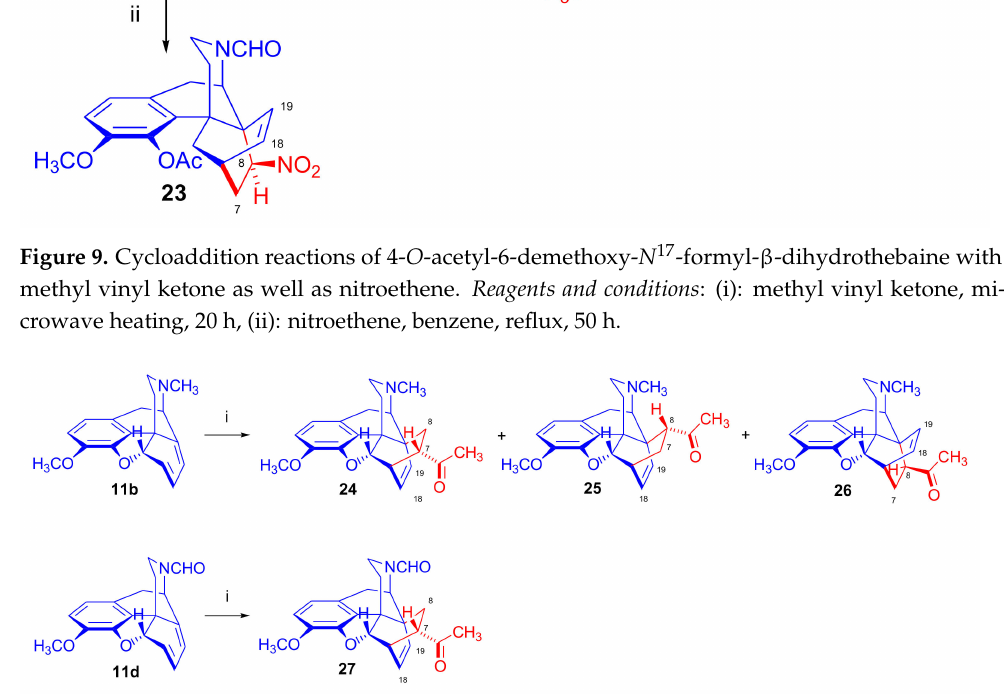
Figure 10. Cycloaddition of methyl vinyl ketone to 6-demethoxythebaine as well as to N 17 -formyl-6- demethoxythebaine. Reagents and conditions : (i): methyl vinyl ketone, heating, microwave, 4